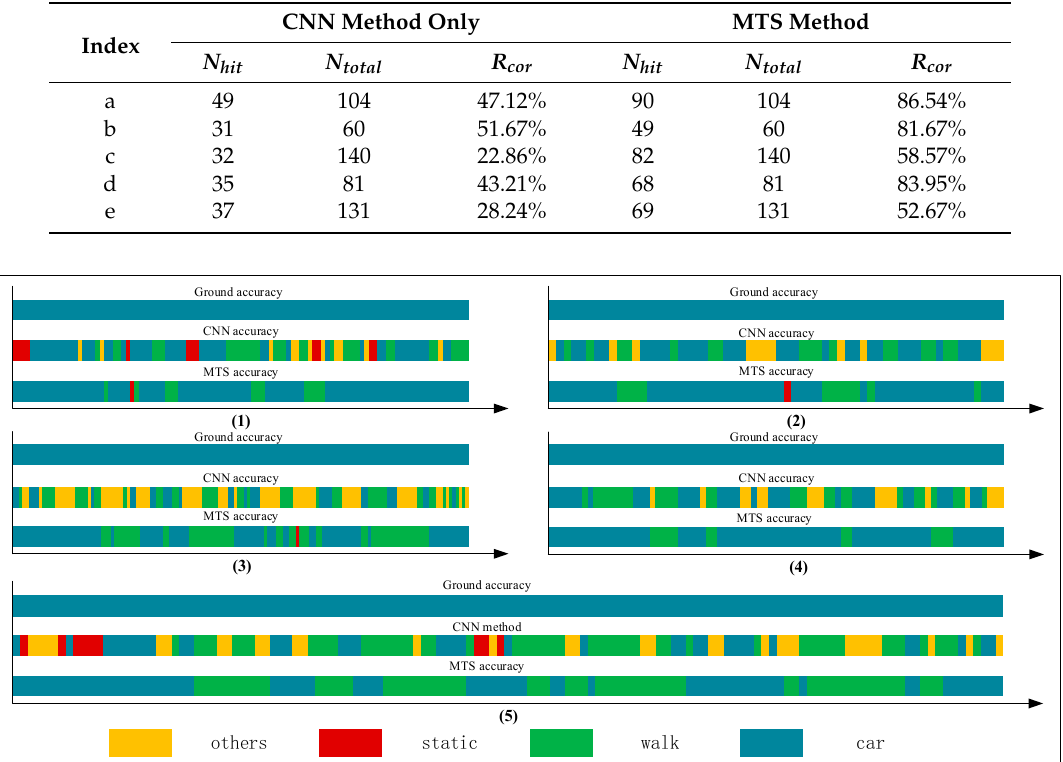
Figure 15. Graphs showing recognition of the in-car state.